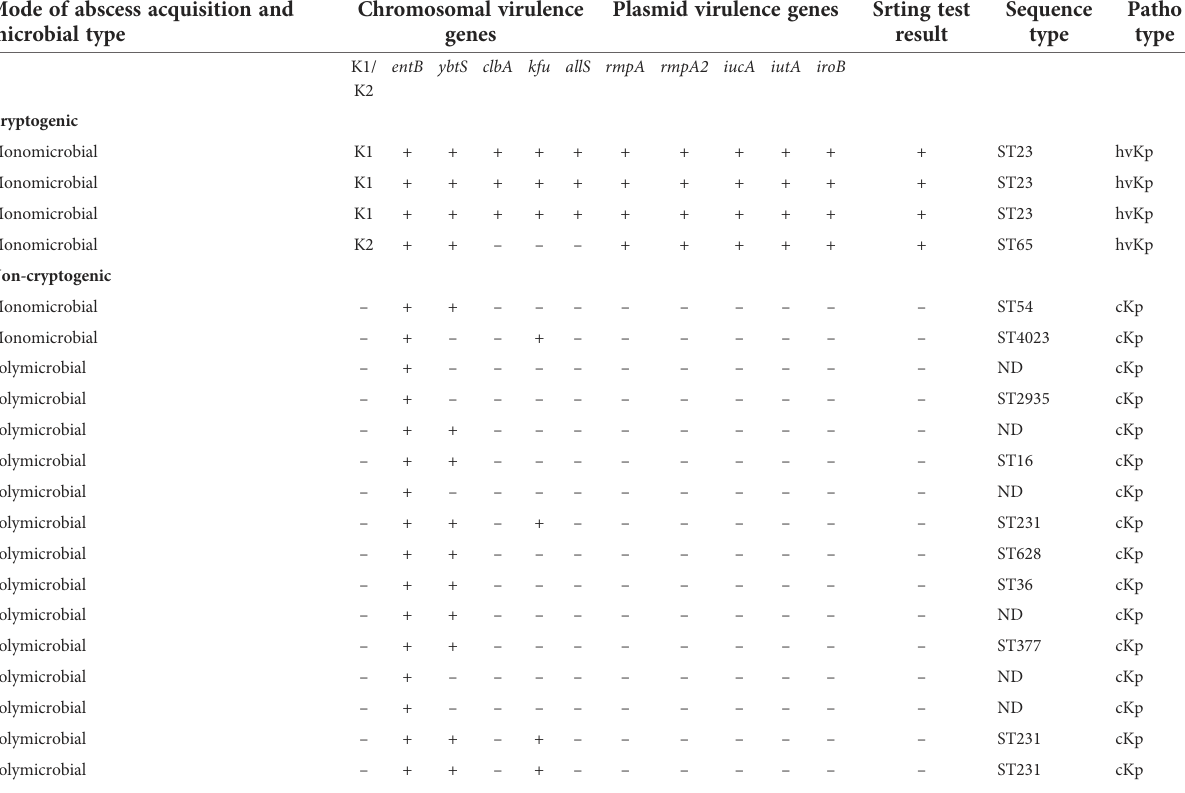
TABLE 2 Characteristics of 20 K . pneumoniae isolates from 4 cryptogenic liver abscesses and 16 non-cryptogenic liver abscesses. Mode of abscess acquisition and microbial